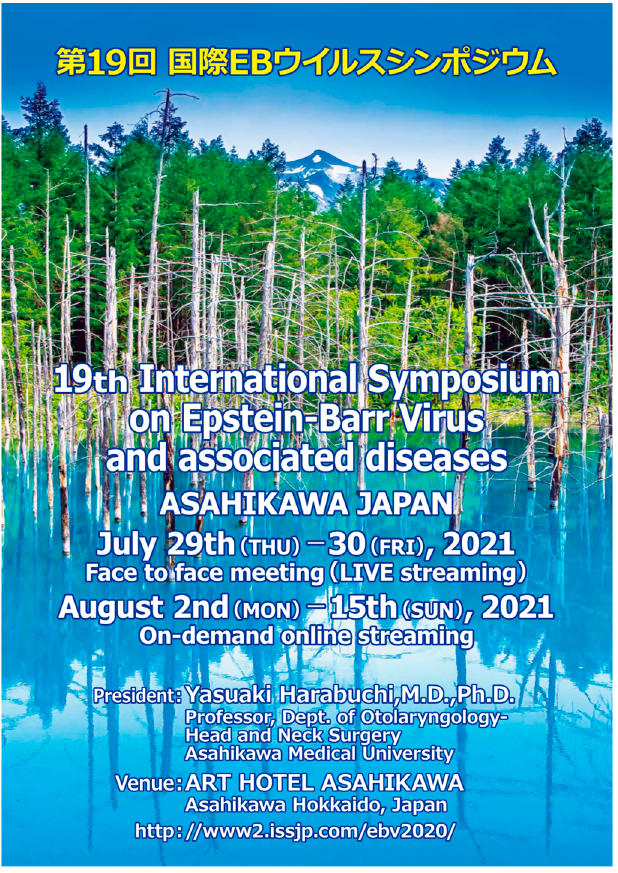
Figure 2. The poster of the 19th International Symposium on Epstein–Barr Virus and Associated Diseases.